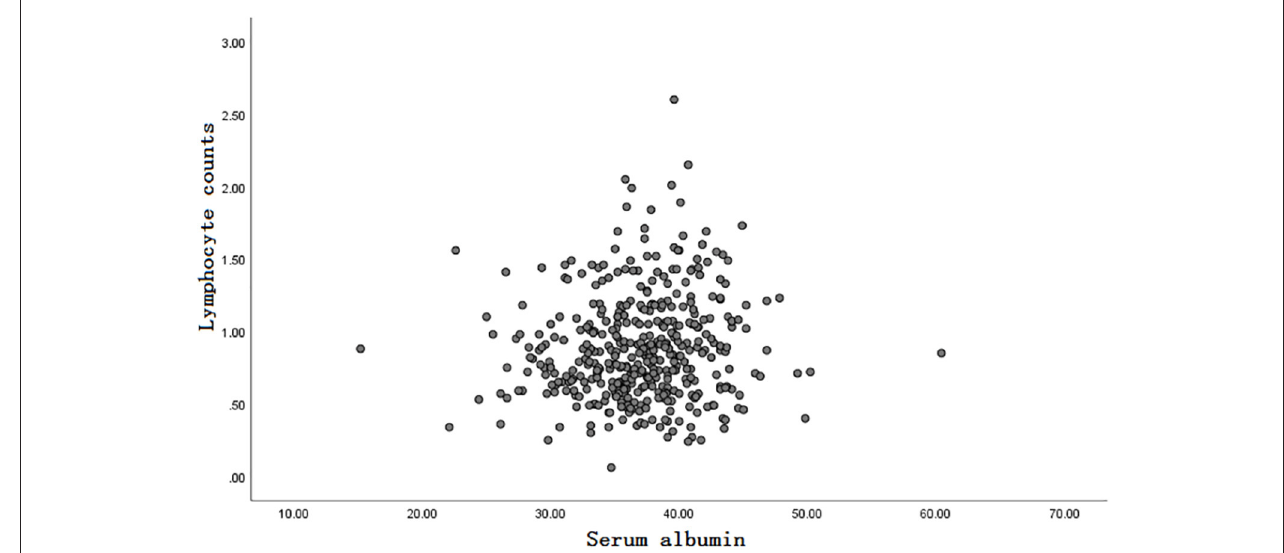
FIGURE 2 | The correlation between absolute lymphocyte count and basal serum albumin.